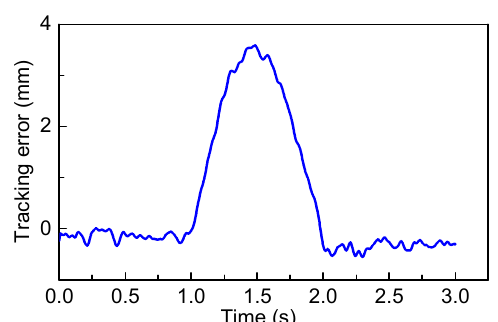
Figure 10. Tracking error using BSTDNDO. Appl. Sci. 2019 , 9 , x FOR PEER REVIEW